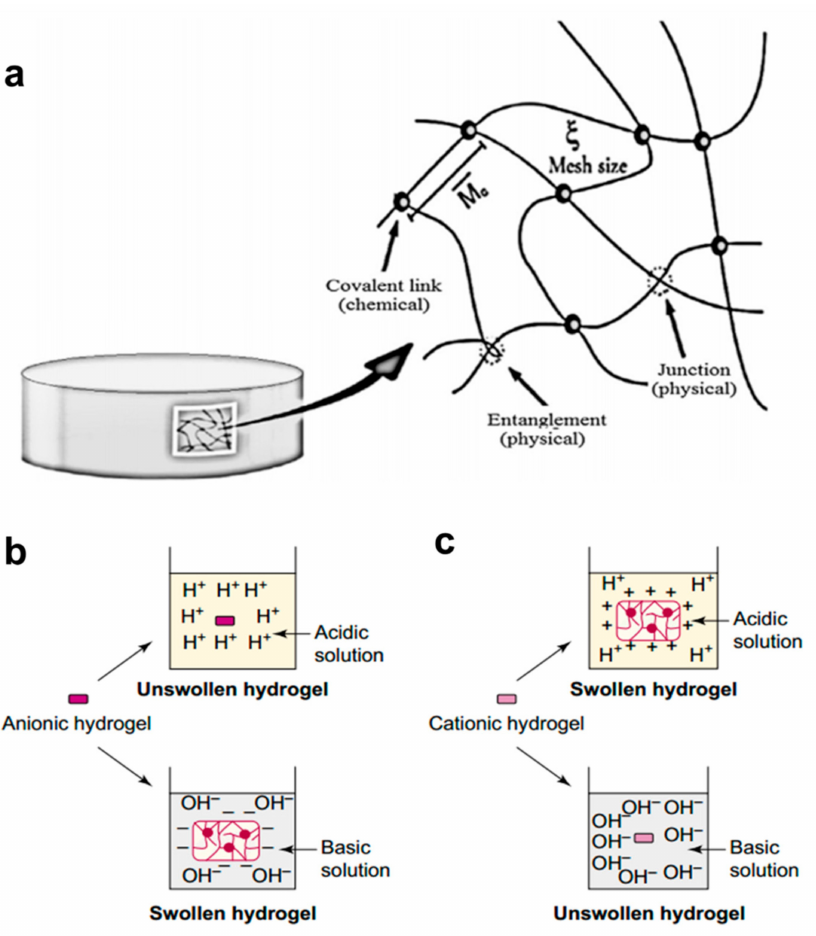
Figure 2. Hydrogels: ( a ) structural chemistry of a hydrogel [121]; ( b , c ) the pH-responsive swelling of anionic ( b ) and cationic ( c ) hydrogels